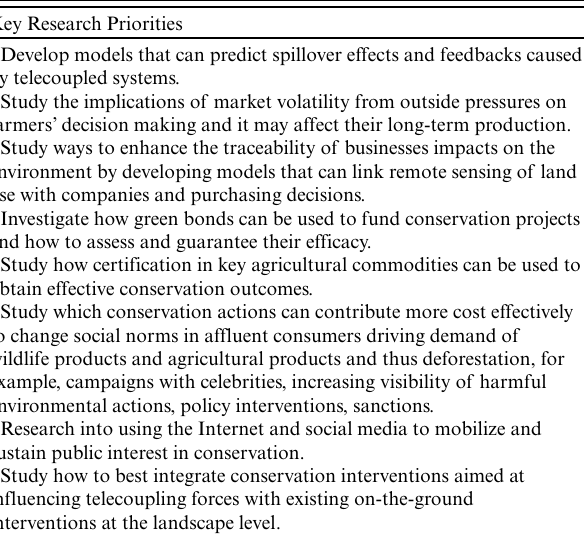
Table 1 . Key research priorities to boost conservation in a telecoupled